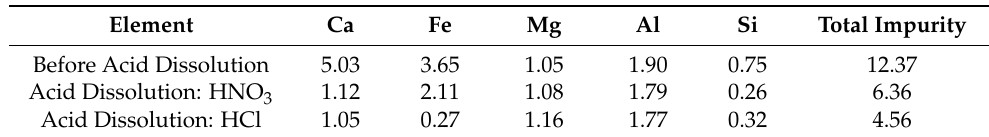
Table 4. The content (wt %) of main elements before and after dissolution of impurities with different acids.